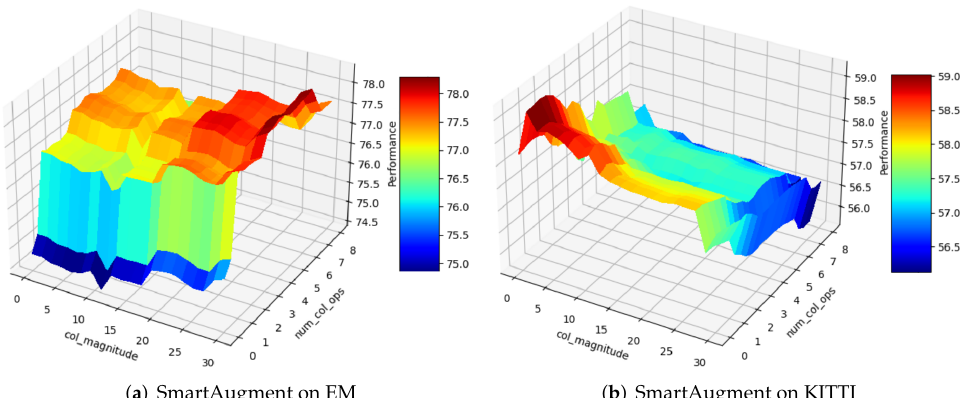
Figure 6. The impact of hyperparameters on different datasets based on performance metric mean IoU. This figure shows that the good values for each hyperparameter depend on the dataset. In this example, higher number of color ops and color magnitude is optimal for EM dataset but detrimental for KITTI